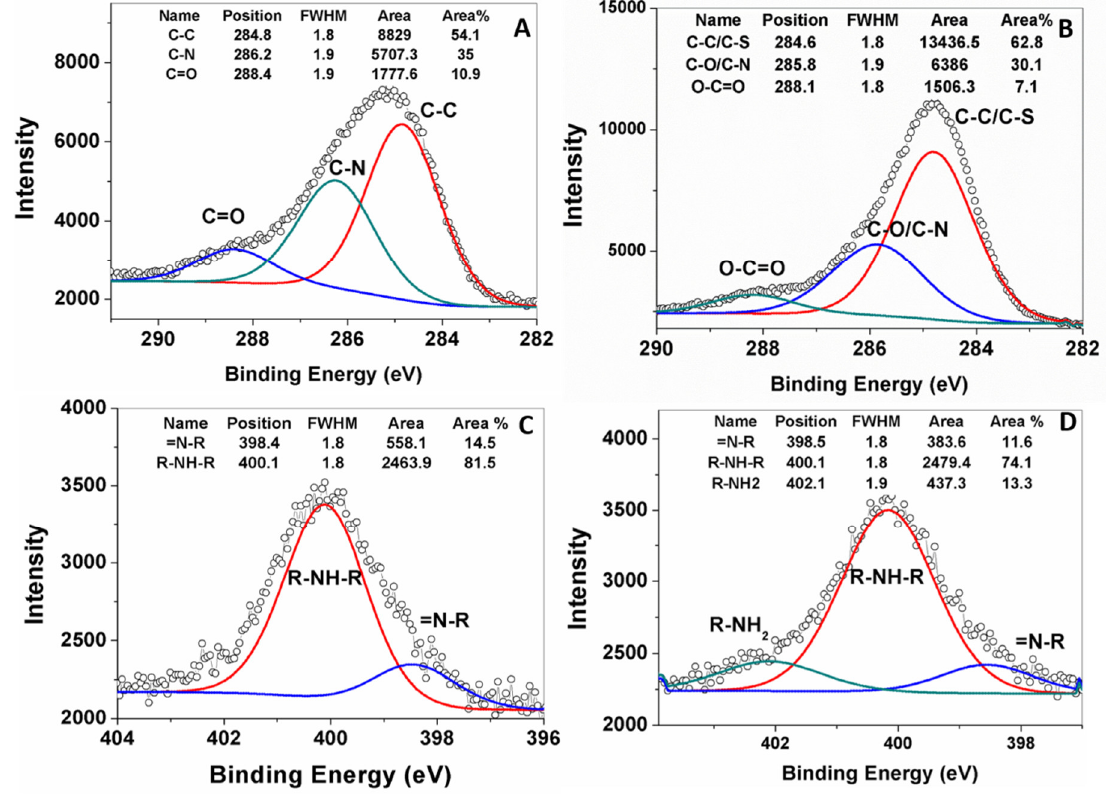
Figure 5. Fitted spectra of C (1s) for ( A ) pDA-IONPs; ( B ) GSSG functionalized pDA-IONPs; and of N (1s) for ( C ) pDA-IONPs; ( D ) GSSG functionalized pDA-IONPs.